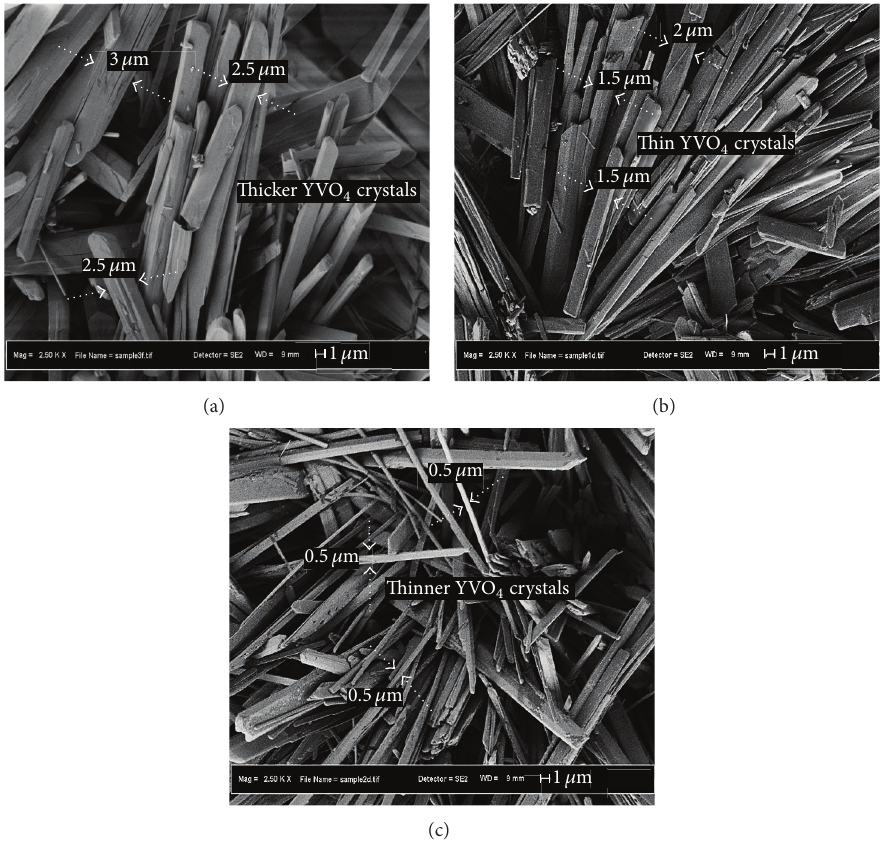
Figure 12: FESEM micrographs of YVO 4 crystals on the surface of YSZ coatings: (a) thicker rod/flat crystals in conventional YSZ, (b) thin rod/flat crystals in YSZ as inner layer of YSZ/normal Al 2 O 3 coating, and (c) thinner rod/flat or needle crystals in YSZ as inner layer of YSZ/nano-Al 2 O 3 coating after hot corrosion testing.